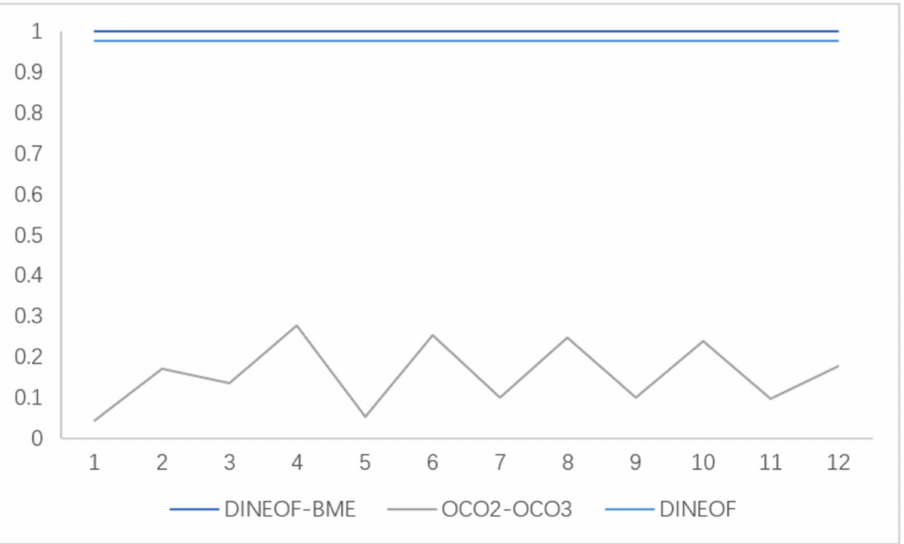
Figure 8. Coverage of OCO Data, DINEOF Interpolation Results and DINEOF in combination with BME interpolation